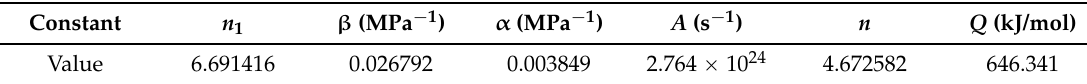
. ε Figure 4. The plots of ( a ) ln -ln r sinh p ασ qs ; and ( b ) ln r sinh p ασ qs -1 { T . Figure 4. The plots of ( a ) ln -ln[sinh( Table 2. Material parameters for peak Table 2. Material parameters for peak stress.